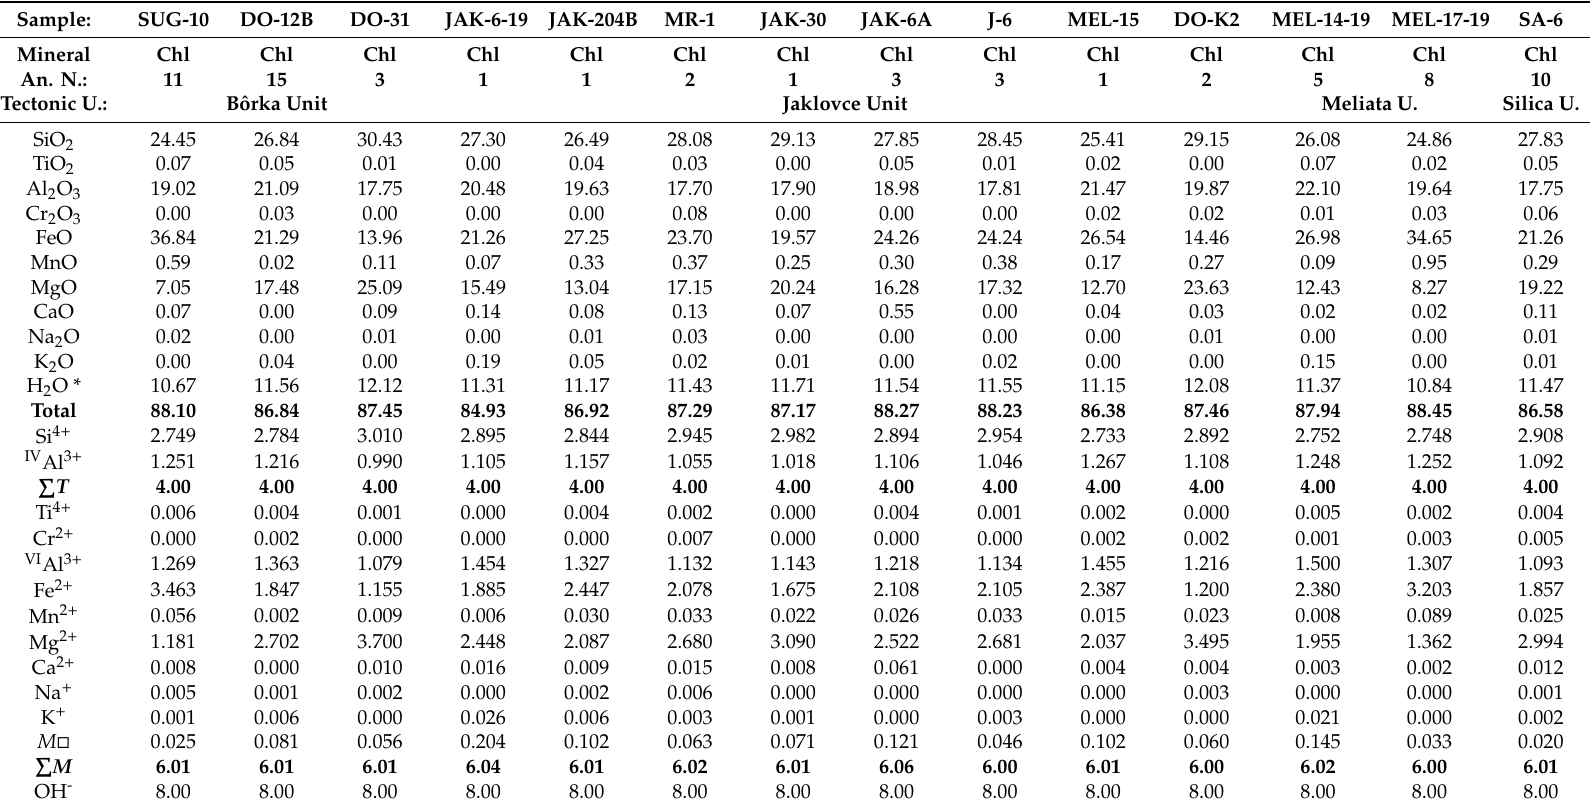
Table 5. Representative analyses of chlorite from the B ô rka, Jaklovce, Meliata and Silica